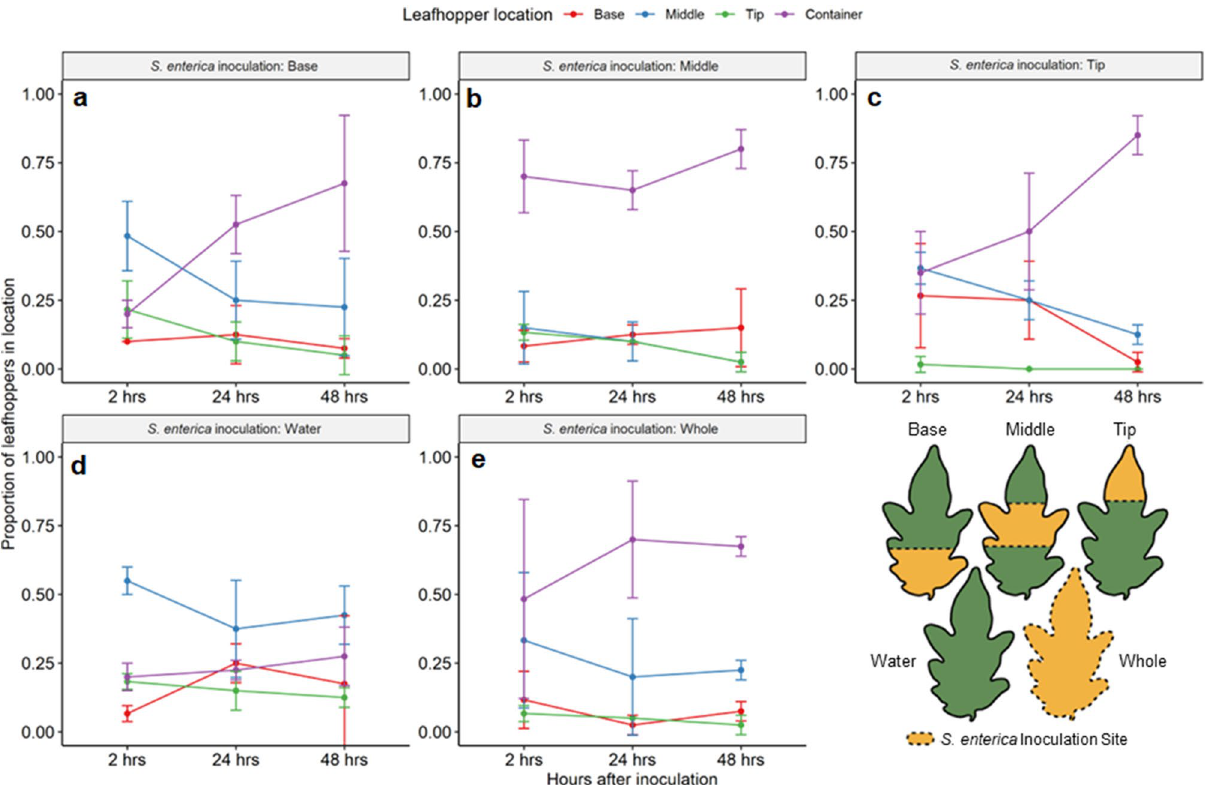
Figure 5. The proportion of M. quadrilineatus that emigrate away from leaflets inoculated with S. enterica increase over 48 h. Tomato leaflets were inoculated with S. enterica exclusively at the basal ( a ), middle ( b ) or tip ( c ) regions or were entirely submerged during inoculation (Whole; e ). Similarly, one group of tomato leaflets were entirely inoculated by water (Water; d ). One hour after S. enterica inoculation, five leafhoppers were placed in a container encasing one tomato leaflet, still attached to the plant. Observations were taken 2, 24, and 48 h after the initial infestation period. The proportion of insects within each treatment represent means from across three experimental replicates between four plants (N = 60 adult M. quadrilineatus